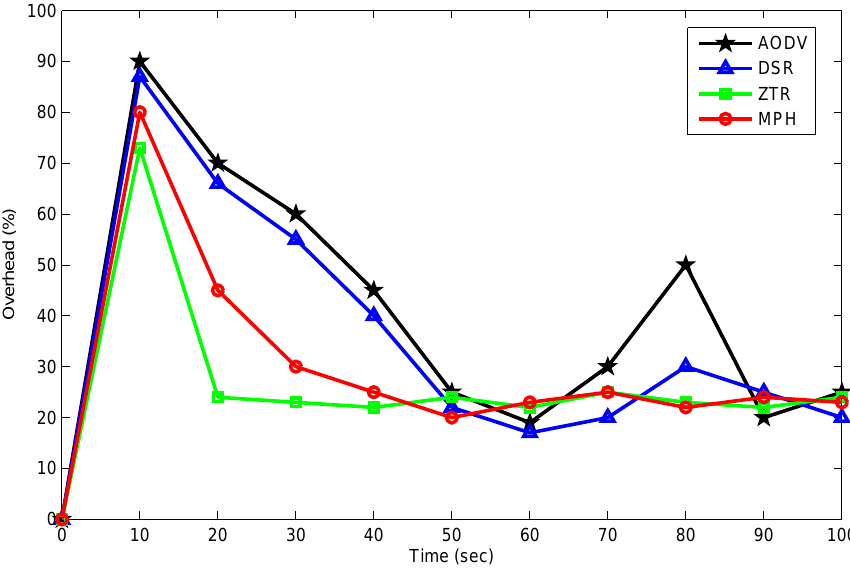
Figure 12. The percent of overhead vs.